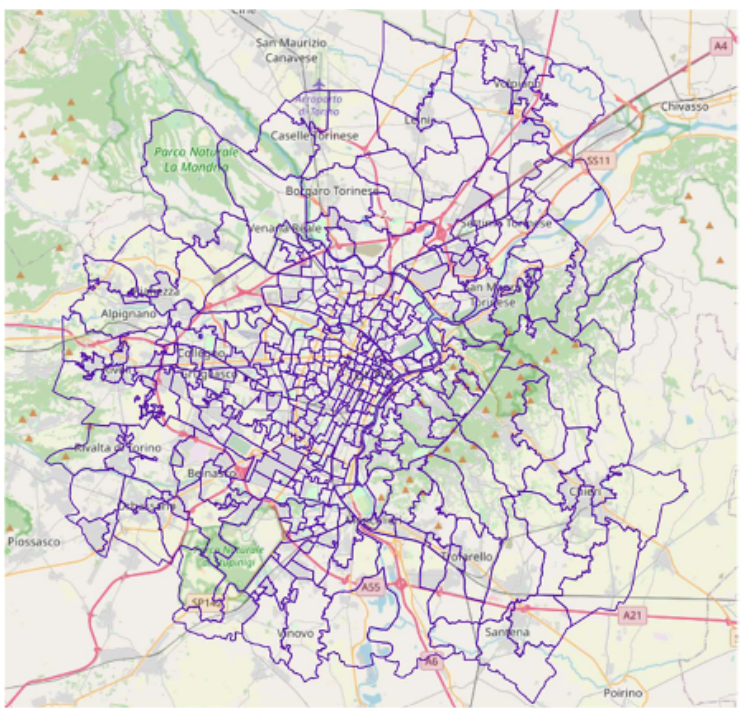
Figure 1. Zoning for the municipality of Turin (166 zones) and its metropolitan area (92 zones).